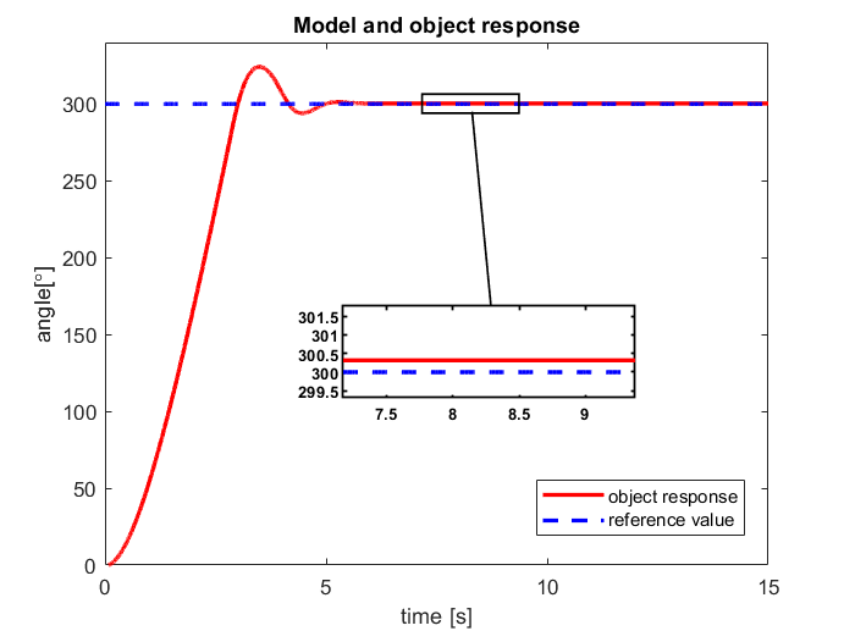
Figure 15. The received angular position of the the sensor-aided object for 300 ◦ reference value (source: